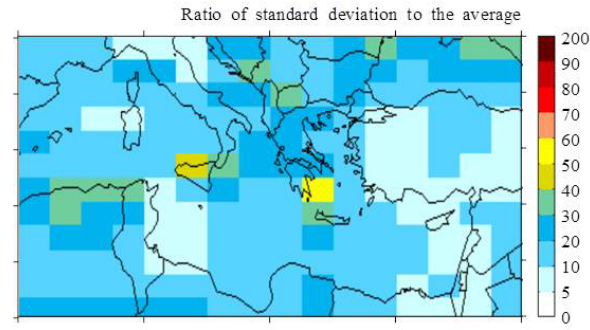
Figure 3. Map of the SD to average ratio of Pcomb deposition over the Mediterranean for the 1997–2012